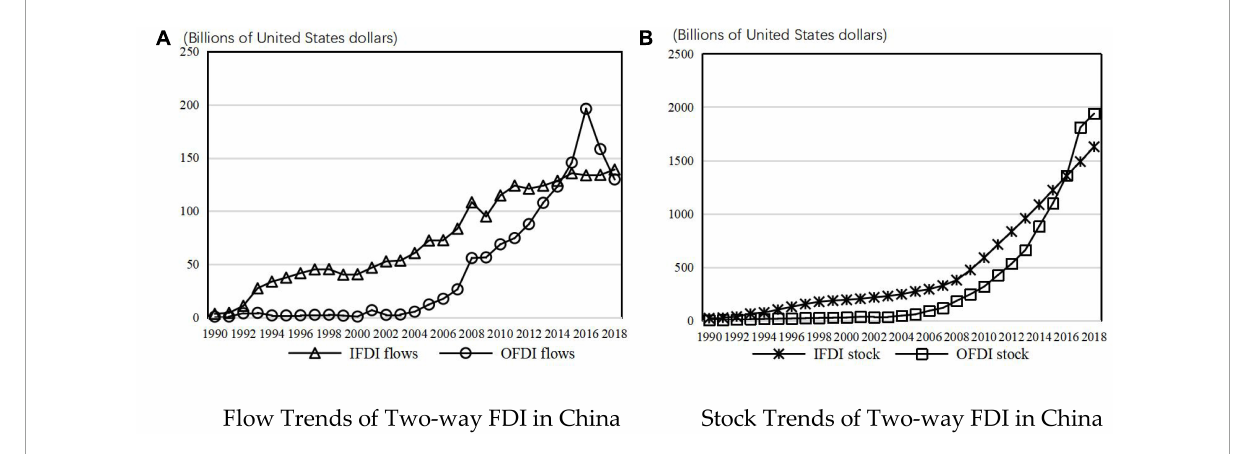
FIGURE1 Flow and stock trends of two-way foreign direct investment (FDI) in China. (A) Flow trends of two-way FDI in China; (B) Stock trends of two-way FDI in